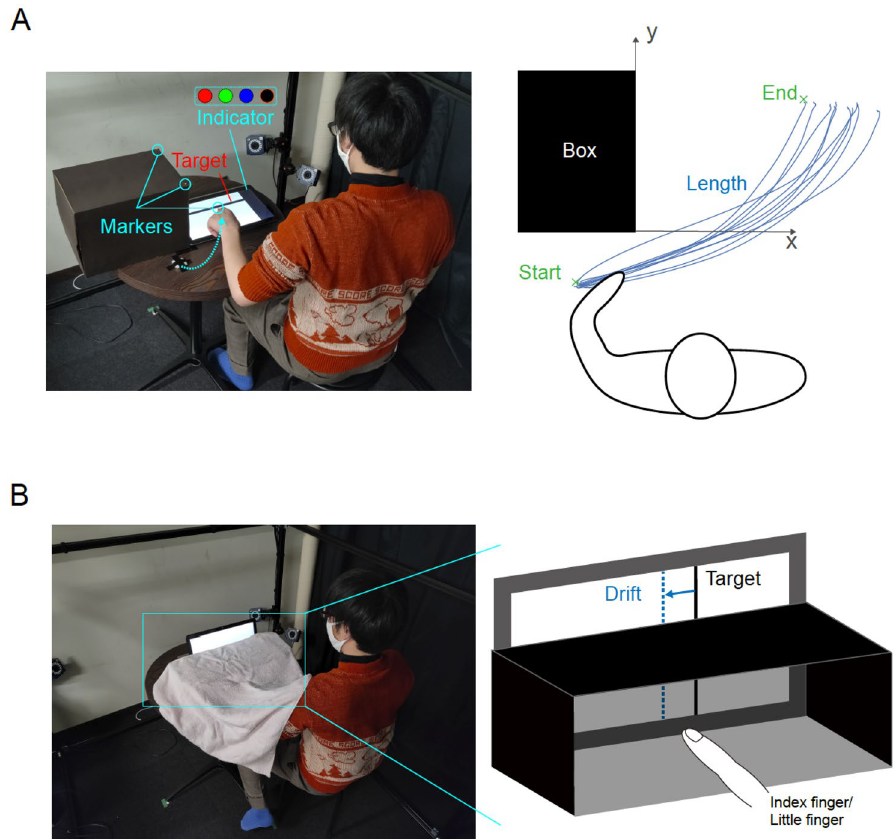
Figure 3. Measurement of body representation changes. ( A ) Schematic of the reaching test. A rectangular- shaped obstacle was placed in front of the participant’s left arm and a tablet PC was placed to the right of it. A target bar and an indicator were displayed on the screen. ( B ) Schematic of the finger localization test. An open box (without the front and back faces) and a PC standing behind it were placed in front of a participant. A target bar was displayed on the screen. The participants touched the target bar with either their index or little